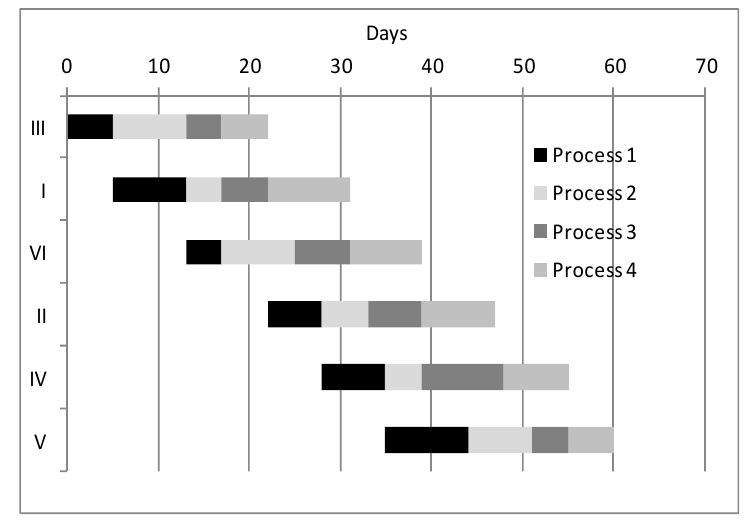
Figure 2. Project schedule with the optimal sequence of work zones and continuous work.